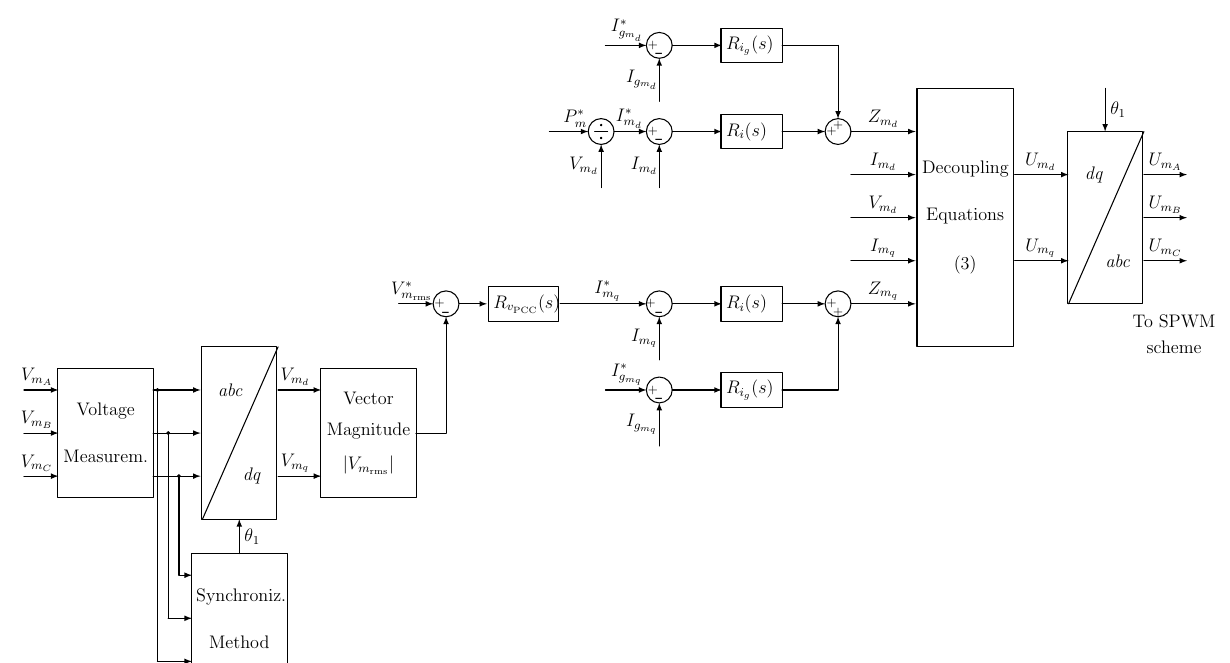
Figure 5. Proposed control scheme of the VSC without regulation of the DC voltage across the DC